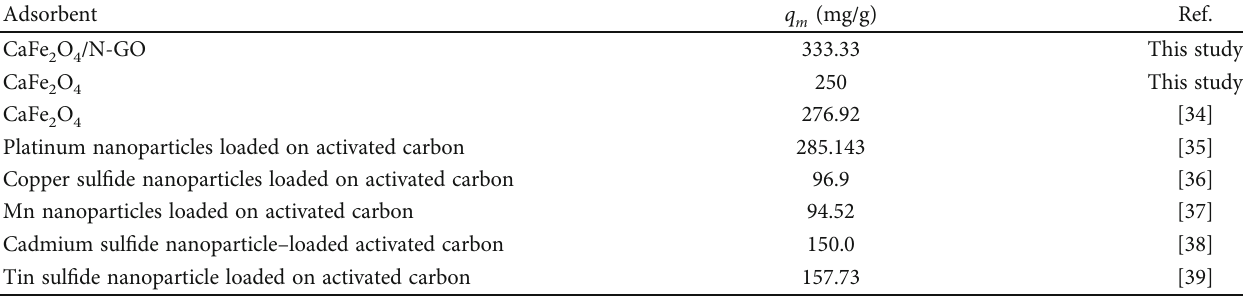
O /N-GO nanocomposite with previously reported adsorbents. 2 4